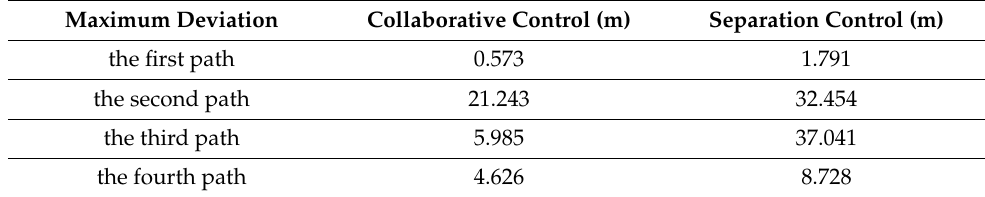
Table 5. Maximum deviation of the collaborative control and separation control.